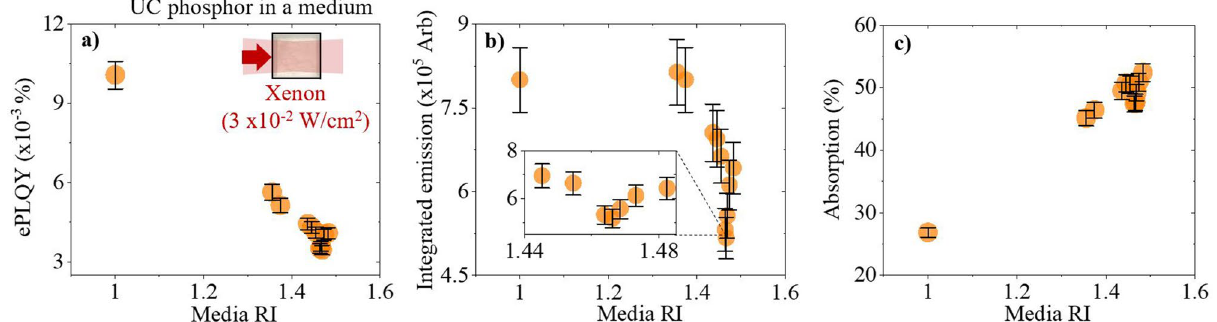
Figure 3. β-NaYF 4 :(18%)Yb 3+ ,(2%)Er 3+ phosphor is placed in air or a transparent medium with varying RI and excited with a 980 nm Xe lamp (orange circle). The following was measured against media RI: ( a ) the ePLQY (500–700 nm), with an inset depiction of the excitation conditions inside each sample, ( b ) the integrated emission (500–700 nm) with an inset magnification of the data points between n = 1.44–1.485, and ( c ) the excitation source in the low PD regime. The phosphor is embedded in range of media with 1 < n < 1.5, which are transparent to the NIR. As seen in Fig. 3a, the ePLQY scales with RI disparity; it is highest for n = 1 and lowest for n = 1.466, when the sample is most transparent. The determined phosphor RI of n = ~1.466 is similar to the value previously reported 27 . From RI-matched medium to air, the ePLQY (500–700 nm) increases by 181%. The integrated emission, seen in Fig. 3b, follows a similar trend; the smallest intensity is observed when the sample is most transparent. However, the influence of the competing beam penetration depth effect can be observed in the highest scattering regimes. Less dopants are excited when there is a large RI disparity, which limits the integrated emission despite the benefits to PD. The absorption, shown in Fig. 3c, is smallest for the lowest RI medium, which corresponds to the high scattering regime. The absorption values increase as scattering decreases, up to a point where changes become small when the RI disparity is low. The associated emission spectra are shown in Fig. S4 of the Supporting Information. Both the green and red UC emissions follow the same trend because thermal and saturation effects are negligible in this PD regime. The influence of the primary inner‑filter effect on the observed upconversion in a high PD regime (0.169 W/cm 2 ). The primary inner-filter effect is another aspect that should be considered when characterizing UC phosphors as it limits the maximum PD of the focal point (FP), which is where the majority of UC is generated. Related to this, the scattering of light away from the areas of highest PD will also be a limitation. Both these effects increase with the length of the beam path in the phosphor material. To test this, the FP from a 980 nm excitation laser diode is moved in the x-axis through the β-NaYF 4 :(18%)Yb 3+ ,(2%)Er 3+ phosphor, as depicted in the inset of Fig. 4a. An equal weight of phosphor is tested in air, as well as ethanol and a RI matched medium. Figure 4a shows the iPLQY of the phosphor at various FP positions, measured from the excitation lens.